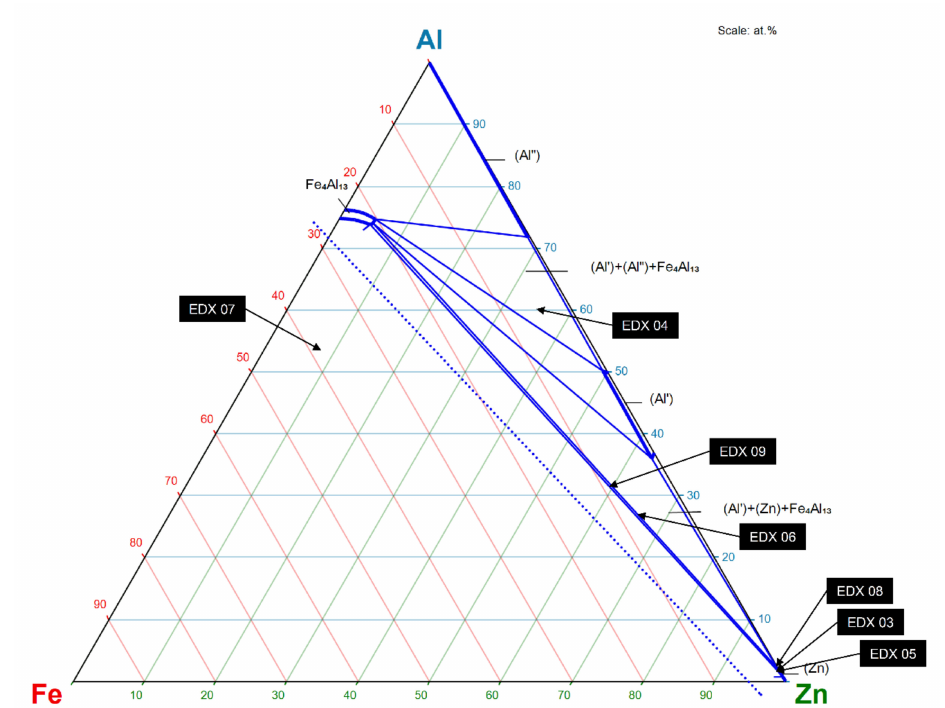
Figure 6. Isothermal section of the ternary system Al-Fe-Zn at 330 ◦ C with EDX points.